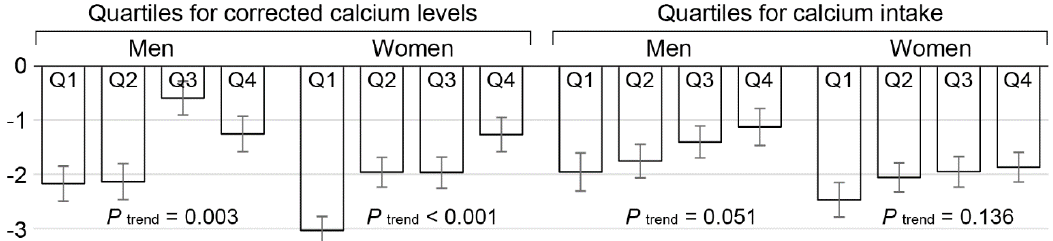
Figure 2. Muscle mass change from baseline to 10th year according to quartiles for corrected calcium levels and daily calcium intake. Decreased muscle mass was observed as quartiles for corrected calcium levels escalated. In contrast, no significant di ff erence in muscle loss was observed according to quartiles for calcium intake in both men and women. Error bars represent